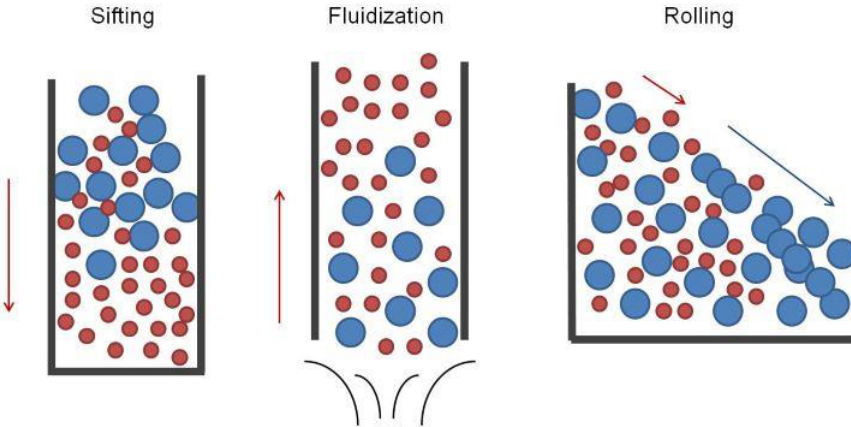
Figure 1. A schematic representation of main particle segregation mechanisms.